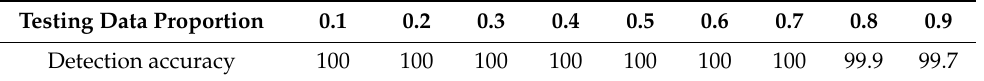
Table 5. Detection accuracy of AE-based